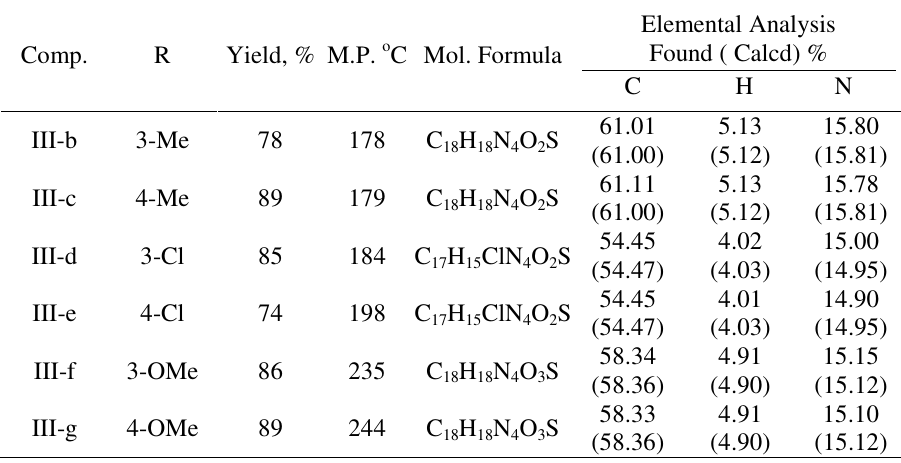
Table 3. General characteristics and elemental analysis data of the compounds